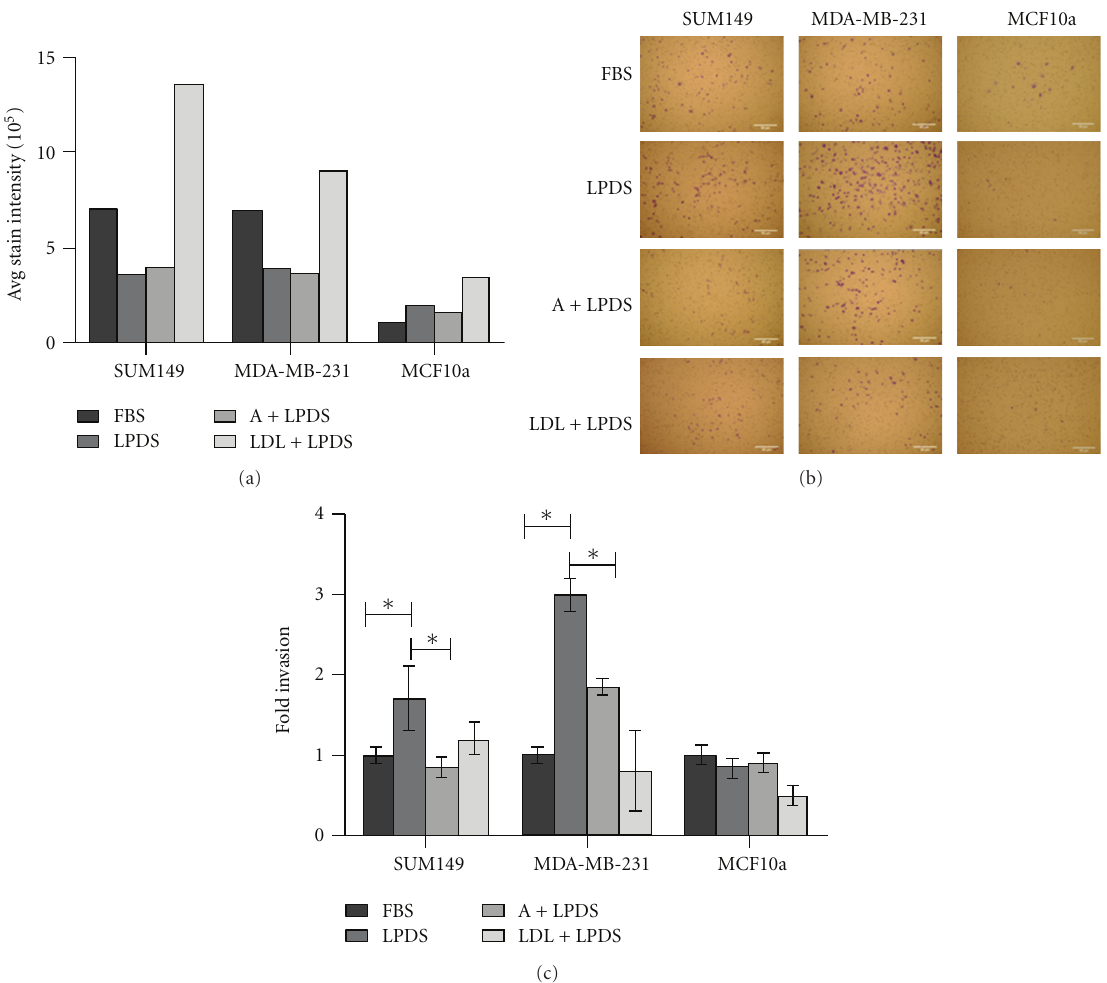
Figure 4: Breast cancer in vitro invasion assays. (a) ORO staining of treatments prior to invasion assay for SUM149, MDA-MB-231, and MCF10a cells, respectively. (b) Representative images of invasion assays. Cells were grown in medium containing FBS (untreated control), LPDS, LPDS with addition of Atorvastatin (A+LPDS) and LPDS with the addition of LDL (LDL+LPDS), resuspended in serum-free medium, placed on a Matrigel coated filter with 8 μ pores and allowed to invade towards a chemoattractant for 22 h. Invaded cells were stained with crystal violet and images taken using a Nikon Eclipes TE-200U. Scale bars represent 50 μ m. (c) Quantitation of invaded cells relative to untreated controls for SUM149, MDA-MB-231, and MCF10a cells, respectively ( ∗ P < 0 . 01). All experiments were performed at least three separate